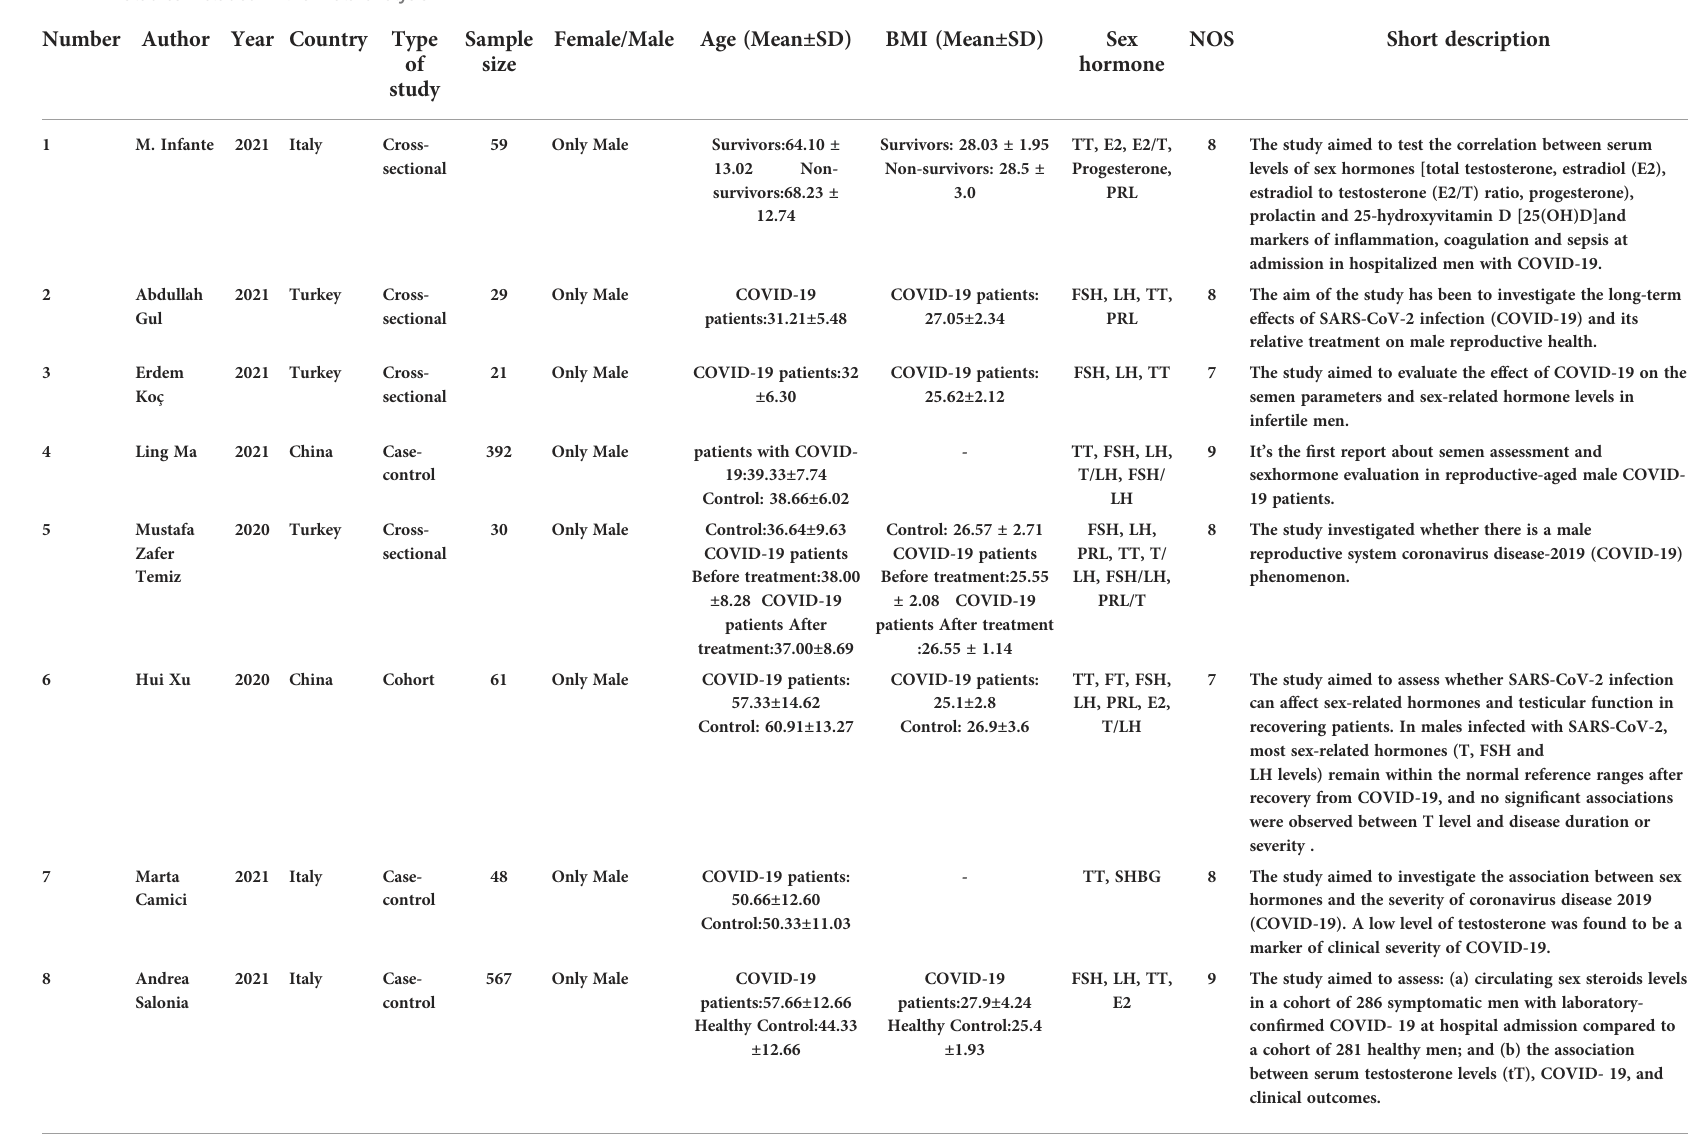
TABLE 1 Studies included in the